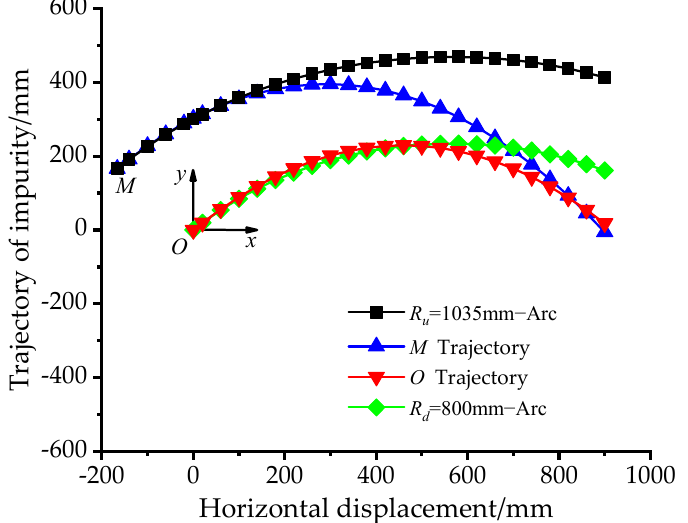
Figure 9. Trajectory of the impurity particles and the ideal curve of the throwing arc segment.